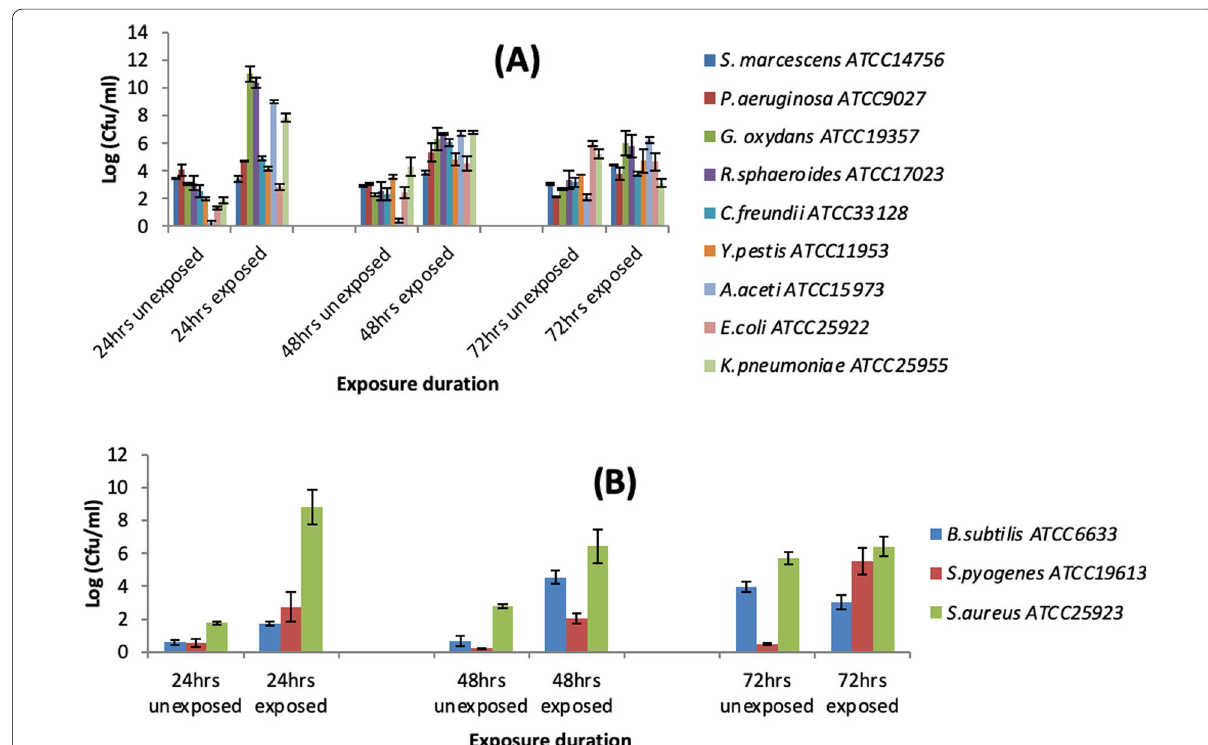
Fig. 1 Growth rate of selected Gram‑negative ( a ) and Gram‑positive bacteria ( b ) after exposure to acoustic treatment at 5000 Hz/90 dB compared with unexposed